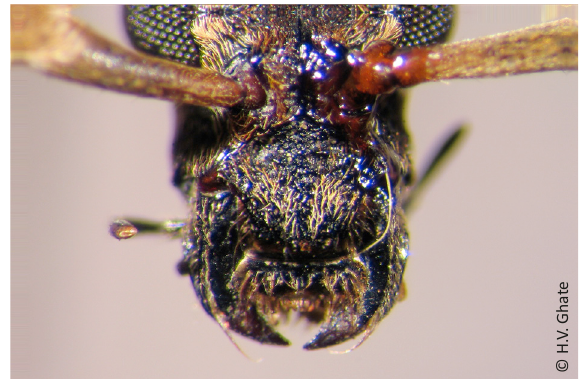
Image 2. Head of Apiocephalus , in frontal view.